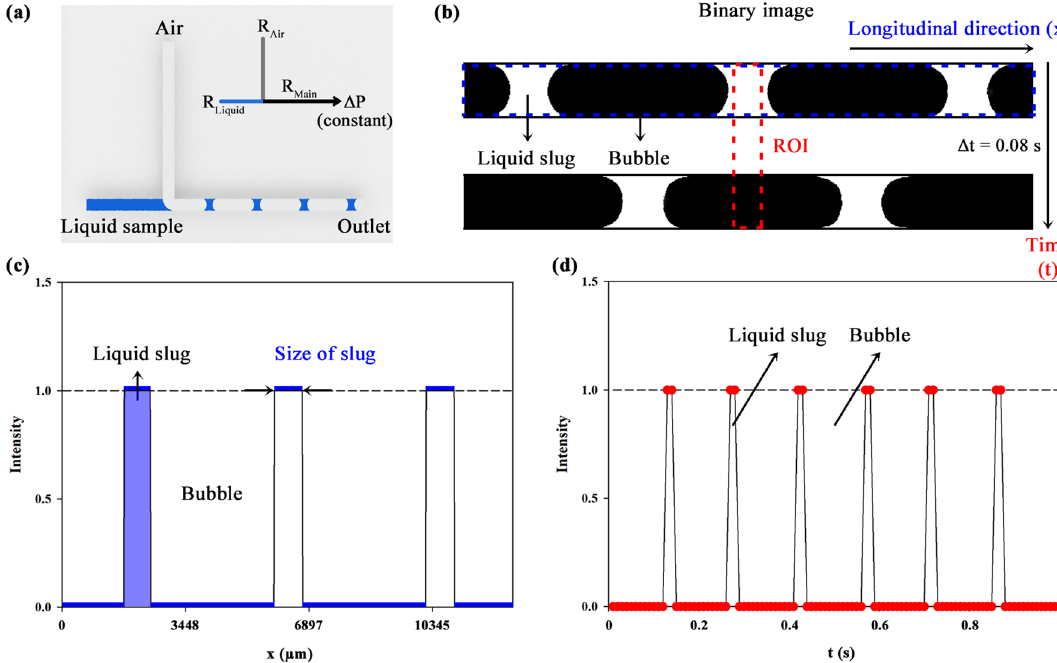
Figure 3. ( A ) Schematic describing hydraulic resistances of air ( R Air ) and liquid ( R Liquid ) flows analogous to the Ohm’s law. A 3D chip was illustrated by the authors using SolidWorks software. ( B ) Binary images converted using the Otsu thresholding method. In the obtained images (Δ t = 0.08 s), the white region represents liquid slugs (intensity value of 1) and the black region represents air bubbles (intensity value of 0). ( C ) Transverse intensity value depending on the longitudinal direction [ x (µm)] at a certain time corresponding to blue box in ( B ). The size of liquid segment ( L S ) is shown in this graph. ( D ) Temporal variation of averaged intensity belonging to ROI depending on time (s) corresponding to red box in ( B ). The flow rate of liquid segment ( Q Liquid ) is shown in this (dispersed fluid). Among two-phase flow patterns, slug flow form shows the dispersion of gas bubbles and concave volume of liquid slugs under wide operating conditions 20 . For steady pressure-driven flow, the relation between flow rate and pressure drop is based on Hagen-Poiseuille’s law 16,49,50 . The constant pressure drop ( ΔP ) induced by one-pump system at the outlet can be expressed as follows: